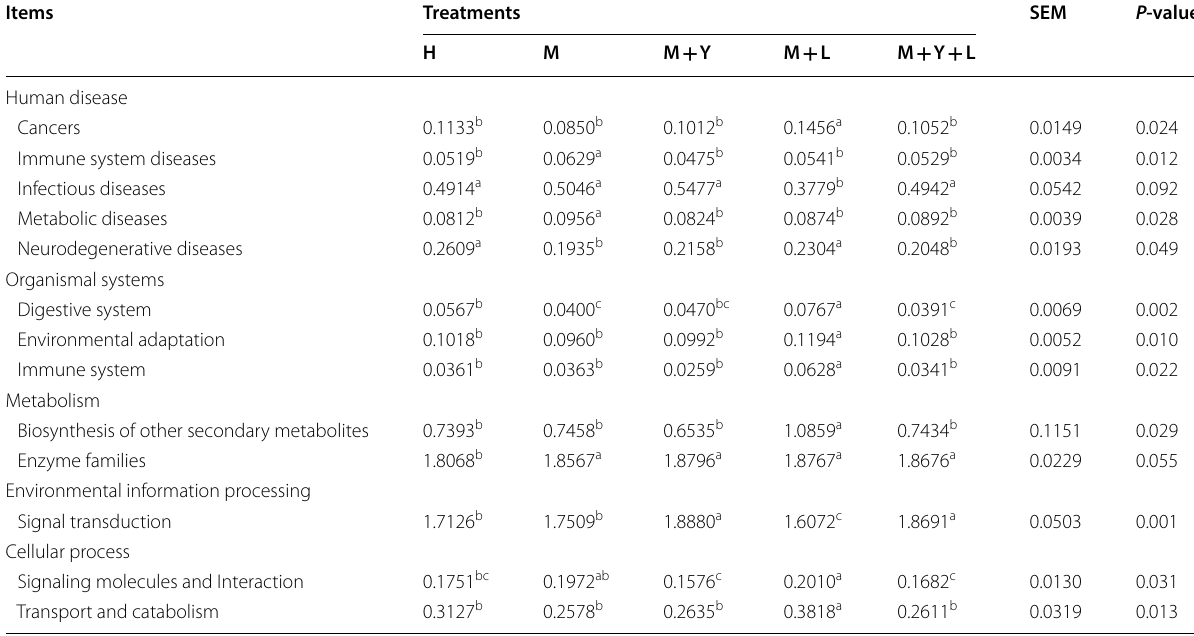
13 level 2 KEGG pathway of milk microbiota are influenced by treatments, which are classified into 5 classfications according to the pathway involved in abc Means in the same row with significant difference ( P <